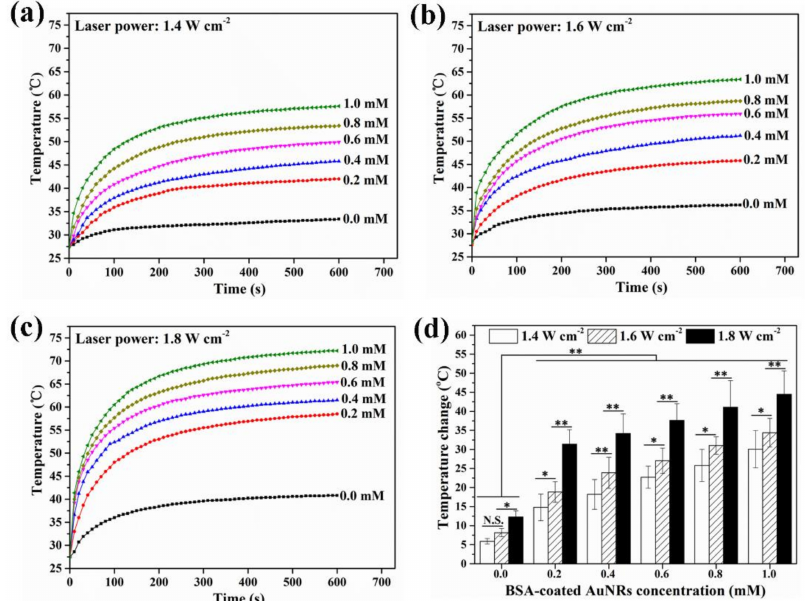
Figure 3. Heating curves of BSA-coated AuNRs aqueous solution at different Au concentration of 0.0, 0.2, 0.4, 0.6, 0.8 and 1.0 mM under continuous NIR irradiation with different laser power intensity of 1.4, 1.6 and 1.8 W cm − 2 ( a – c ). Temperature change of BSA-coated AuNRs aqueous solution at different Au concentration of 0.0, 0.2, 0.4 and 0.6, 0.8 and 1.0 mM after NIR irradiation with different laser power intensity of